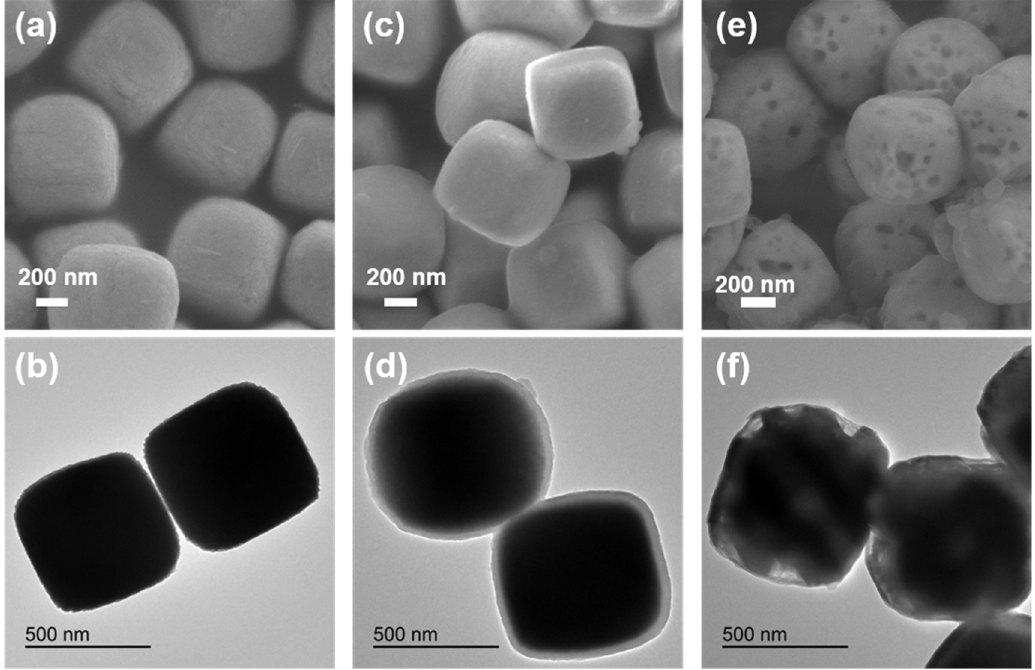
Figure 1. ( a , b ) SEM and TEM images of Fe 2 O 3 precursor; ( c , d ) SEM and TEM images of cube Fe 2 O 3 @PDA; ( e , f ) SEM and TEM images of Fe 3 O 4 @N-doped C sample. Fe 2 O 3 @PDA; ( e , f ) SEM and TEM images of Fe 3 O 4 @N-doped C Figure 2a,b are the SEM and TEM images of Fe 3 O 4 @void@N-doped C-2. It can be seen